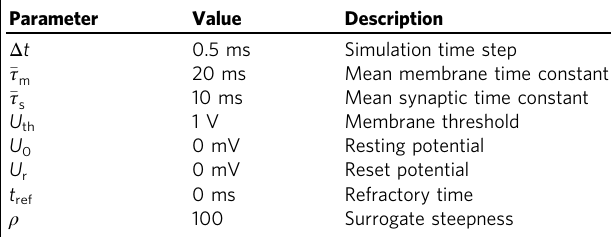
Table 3 Surrogate gradient descent network